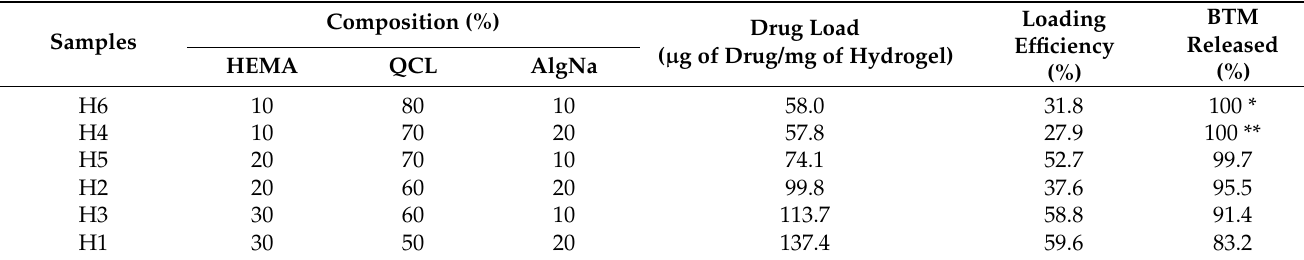
Table 2. Relation between hydrogels’ composition and drug load, loading efficiency, and BTM released.